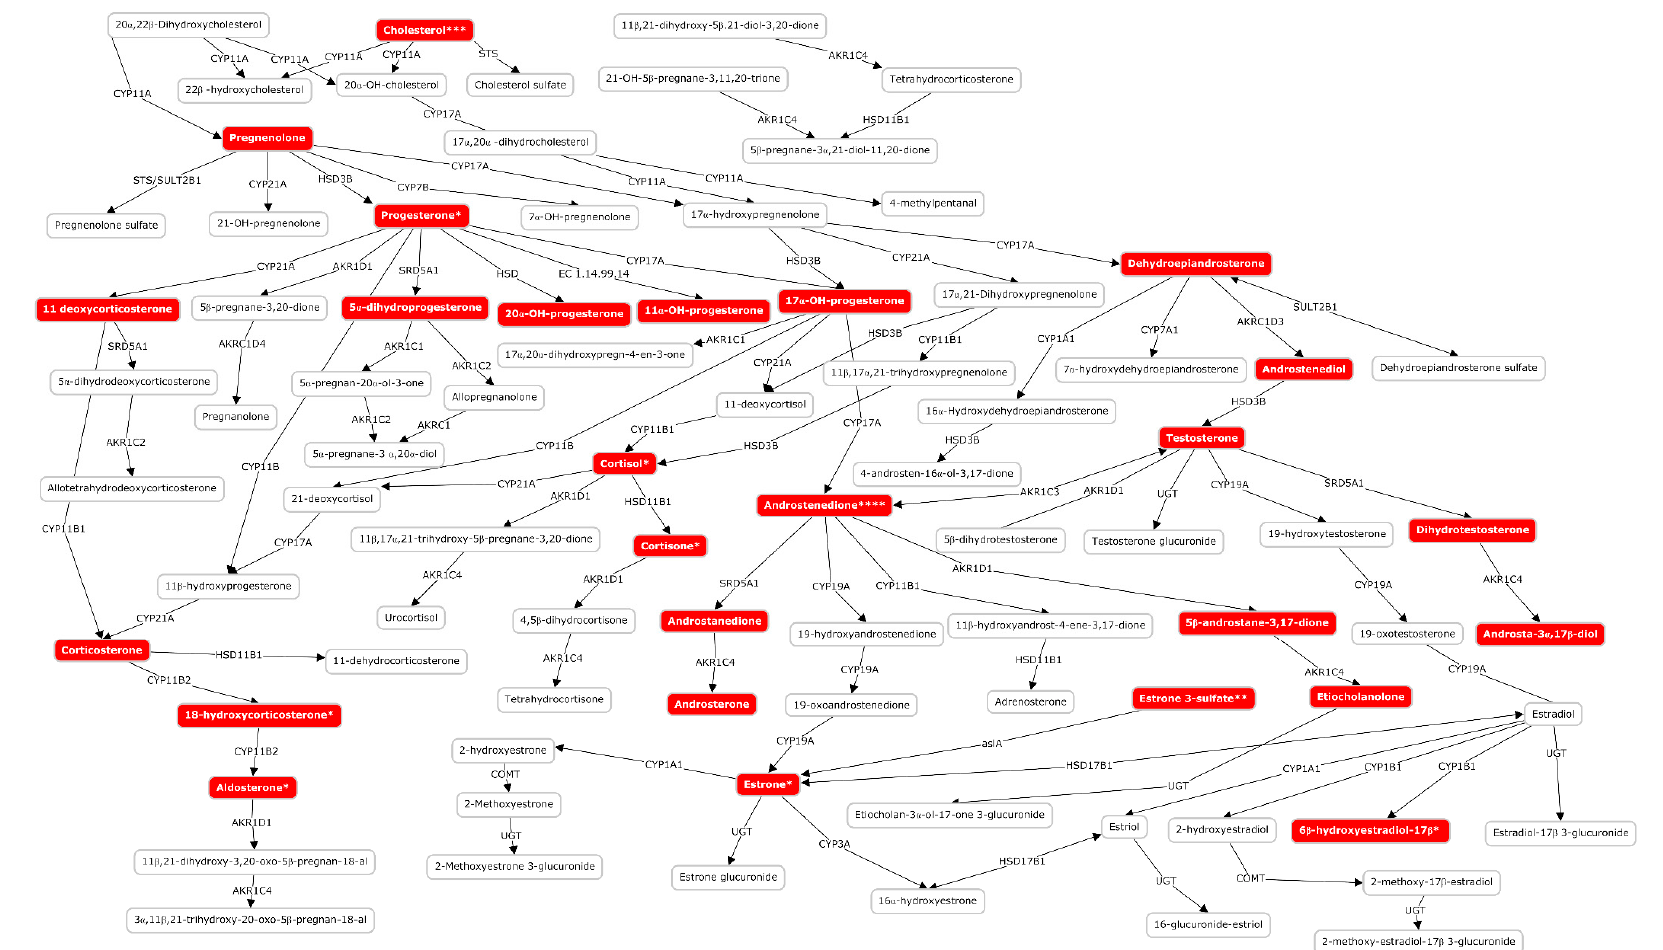
Figure 5. Altered metabolites of the steroid hormone biosynthesis pathway in plasma samples from newborns suffering from HIE at birth and 24, 48, and 72 h after administration of the first dose of medication / placebo. Note: * altered only at 24, 48, and 72 h; ** altered only at 48 and 72 h; *** altered only at 48 h; **** altered only at 72 h.